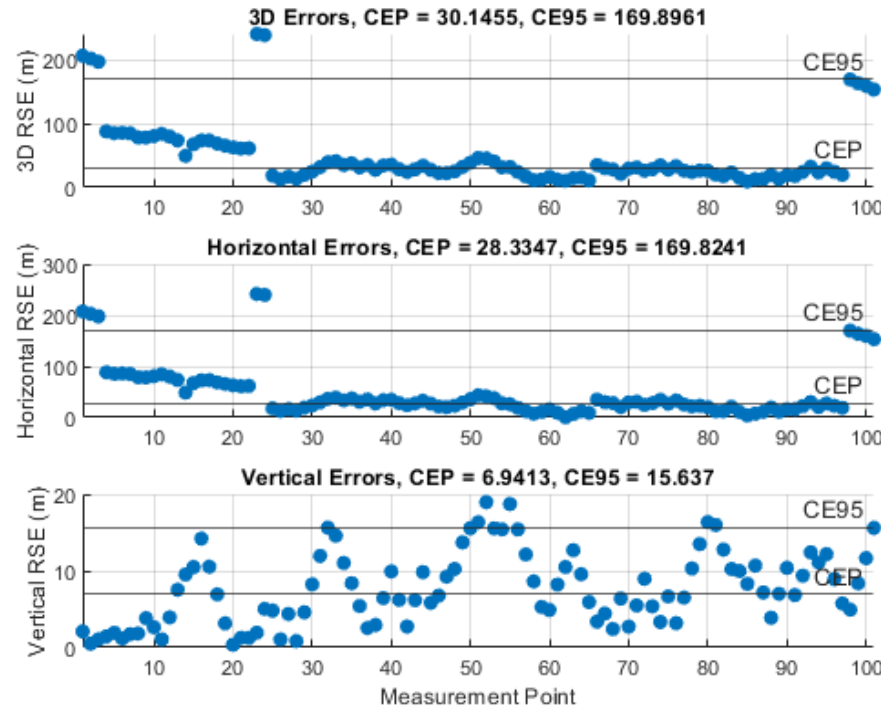
Figure 14. RSE evolution of the IPF solution with a measurement error SD, σ θ , ϕ , of 5 ◦ . All simulation codes were implemented in MATLAB R2020a and were executed on Intel Core i7-8565U central processing unit (CPU) at 1.8 GHz with 24 GB of random- access memory (RAM). The estimated run time of the IPF algorithm (with 1000 particles) to obtain a single emitter location estimate was on the order of 0.3 ms. The